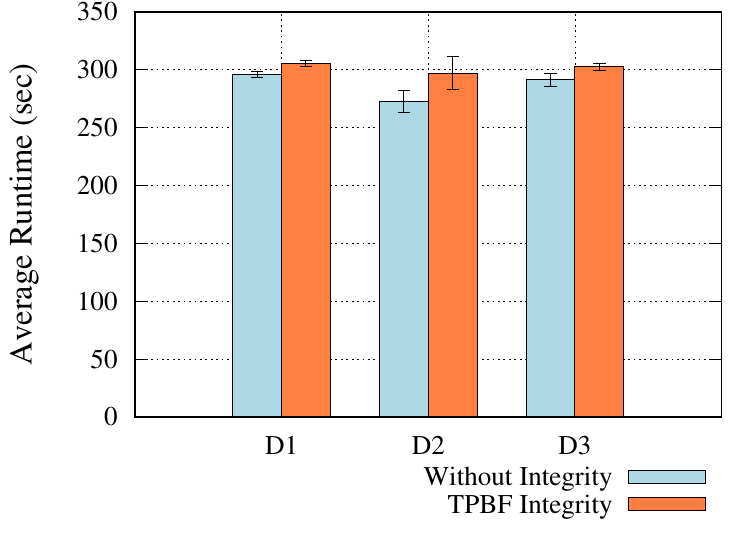
Figure 8. Data transfer